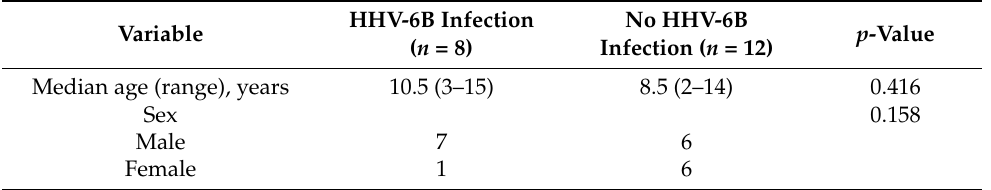
Table 1. Characteristics and clinical features of the